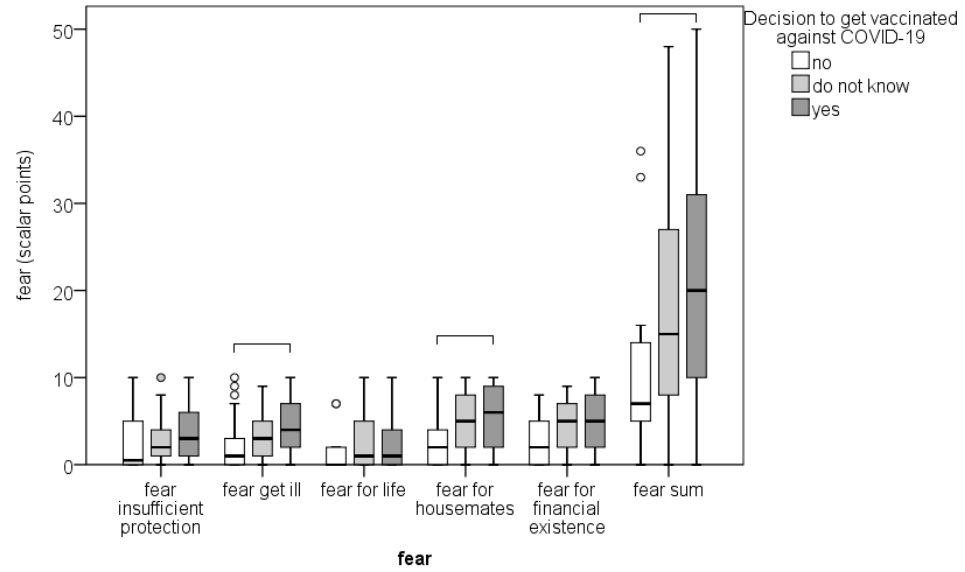
Figure 2. Association of dentists’ fear (scale 0 = no fear to 10 = extreme fear) with the decision to get vaccinated. Box plot represents the median and interquartile range, whiskers represent min and max values, and circles represent outliers. Parentheses connect categories that differ significantly according to Kruskal–Wallis test with Mann–Whitney post hoc test and Bonferroni correction for multiple comparisons.